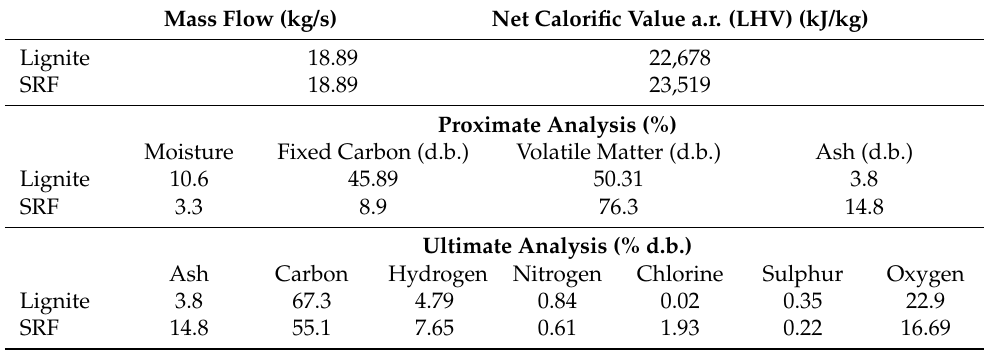
Table 1. Fuel properties and analysis for LEG and SRF deployed in the reference scenario.